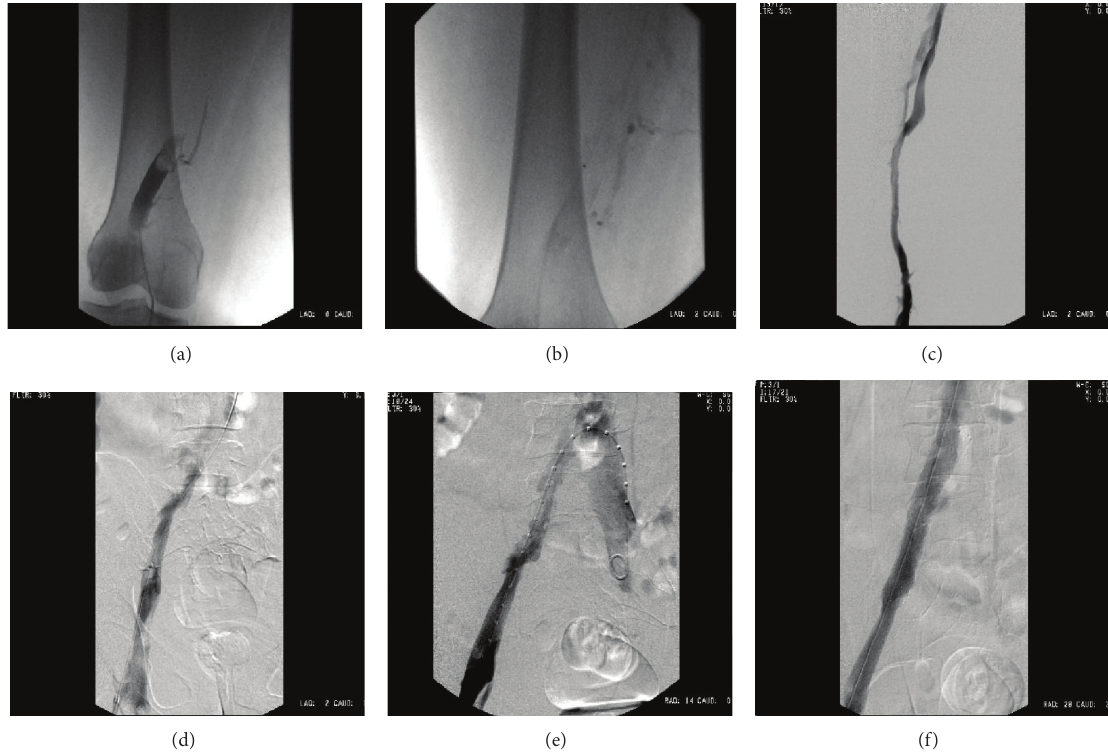
Figure 3: Venography at the day of presentation shows complete thrombotic occlusion of the veins in left leg, dye is not passing beyond popliteal vein ((a) and (b)), (c) demonstrates duplication of the femoral vein. (d), (e), and (f) demonstrate venography at day 3 before and after stent placement,